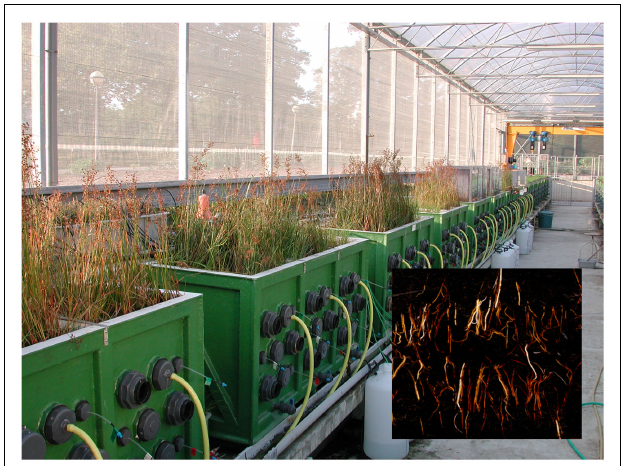
FIGURE 2 |The Nijmegen Phytotron facility, and a scan image of the root scanner in transparent tubes in the soil